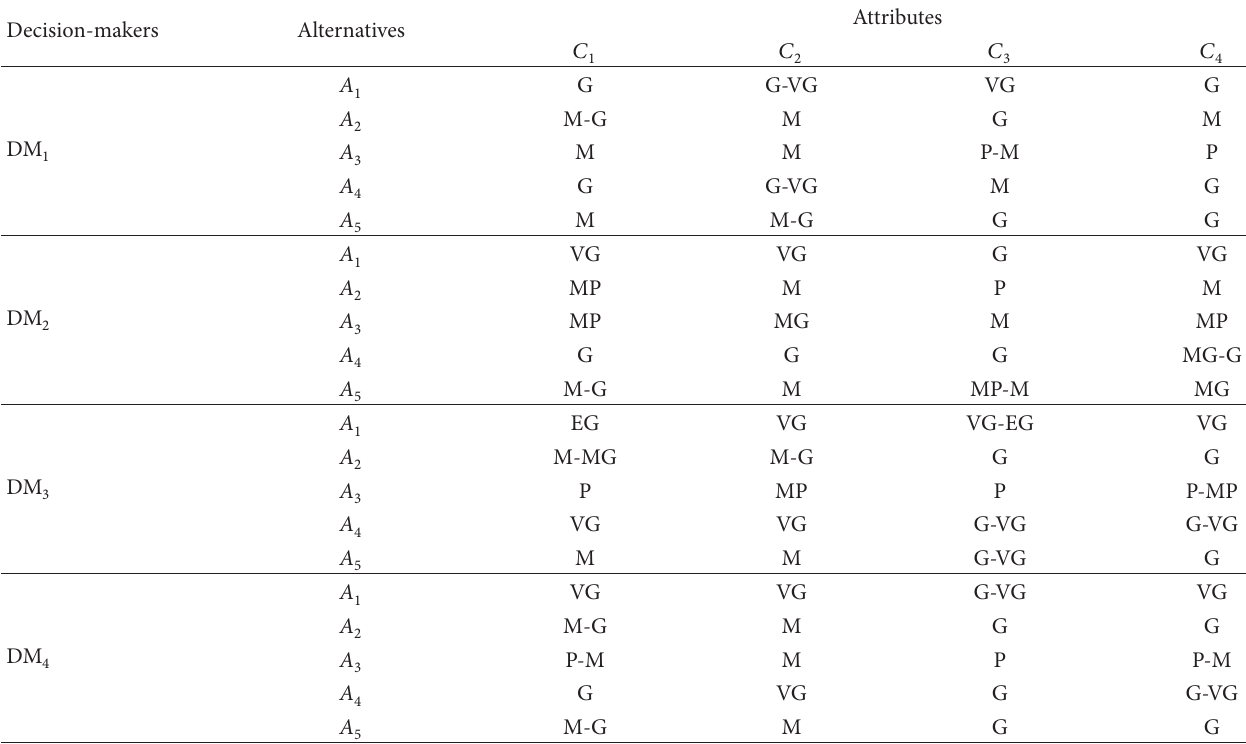
Table 1: Linguistic assessments of the five alternatives.